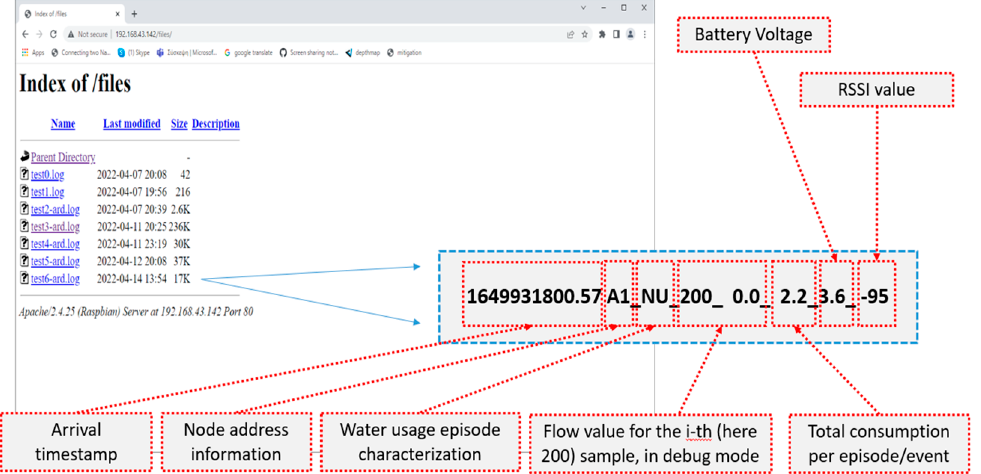
Figure 7. Characteristic details of the water flow episode/event specific information as stored into the log files on the Raspberry Pi Model 3 A+ unit implementing the gateway node. the log files on the Raspberry Pi Model 3 A+ unit implementing the gateway